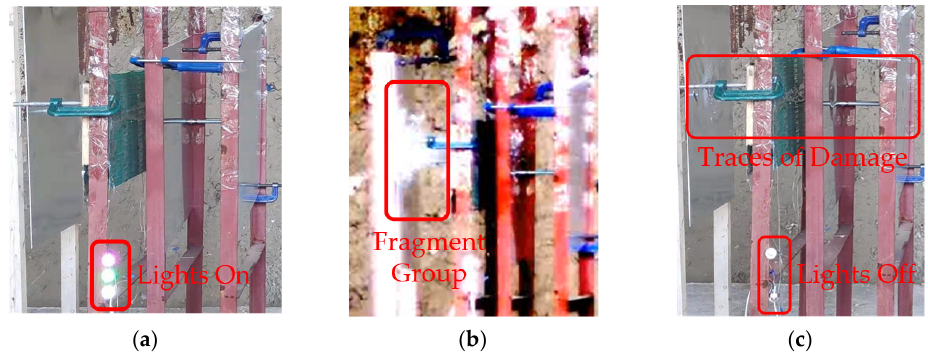
Figure 2. Test configuration. ( a ) Before the damage, the lights were on. ( b ) During the penetration, the damage elements and the plate formed fragments. ( c ) After the damage, the lights were